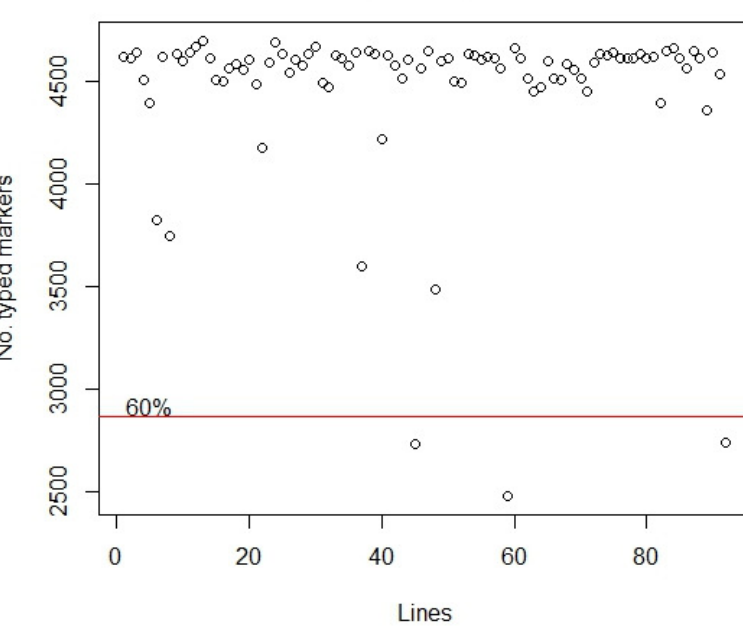
Figure 1. Number of DArTseq markers obtained for each of 92 lines from ExL